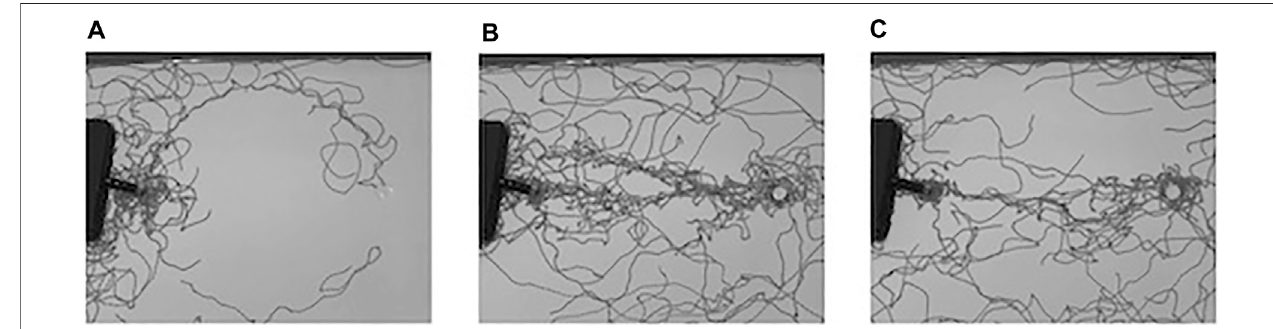
FIGURE 2 | Temporal overlaying of video frames for 60 s from (A) 15 s, (B) 5 min, and (C) 25